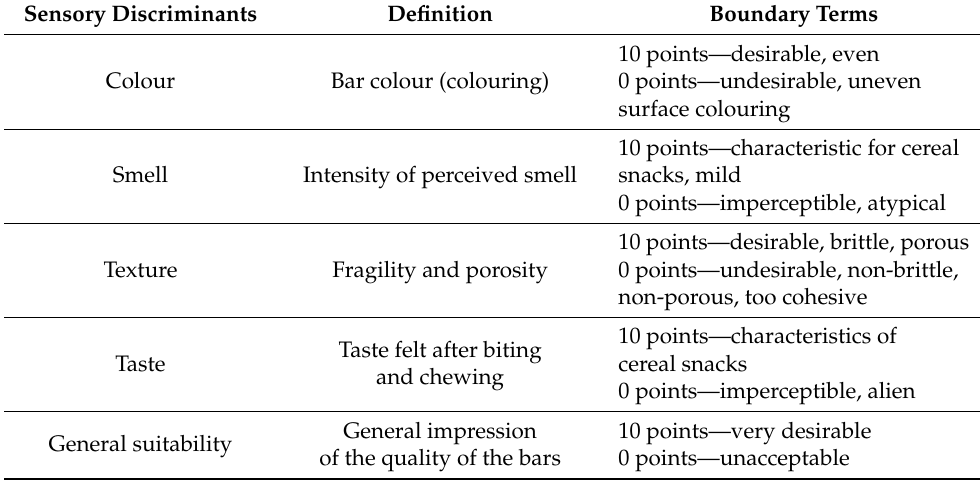
Table 5. Quality features to be assessed and their